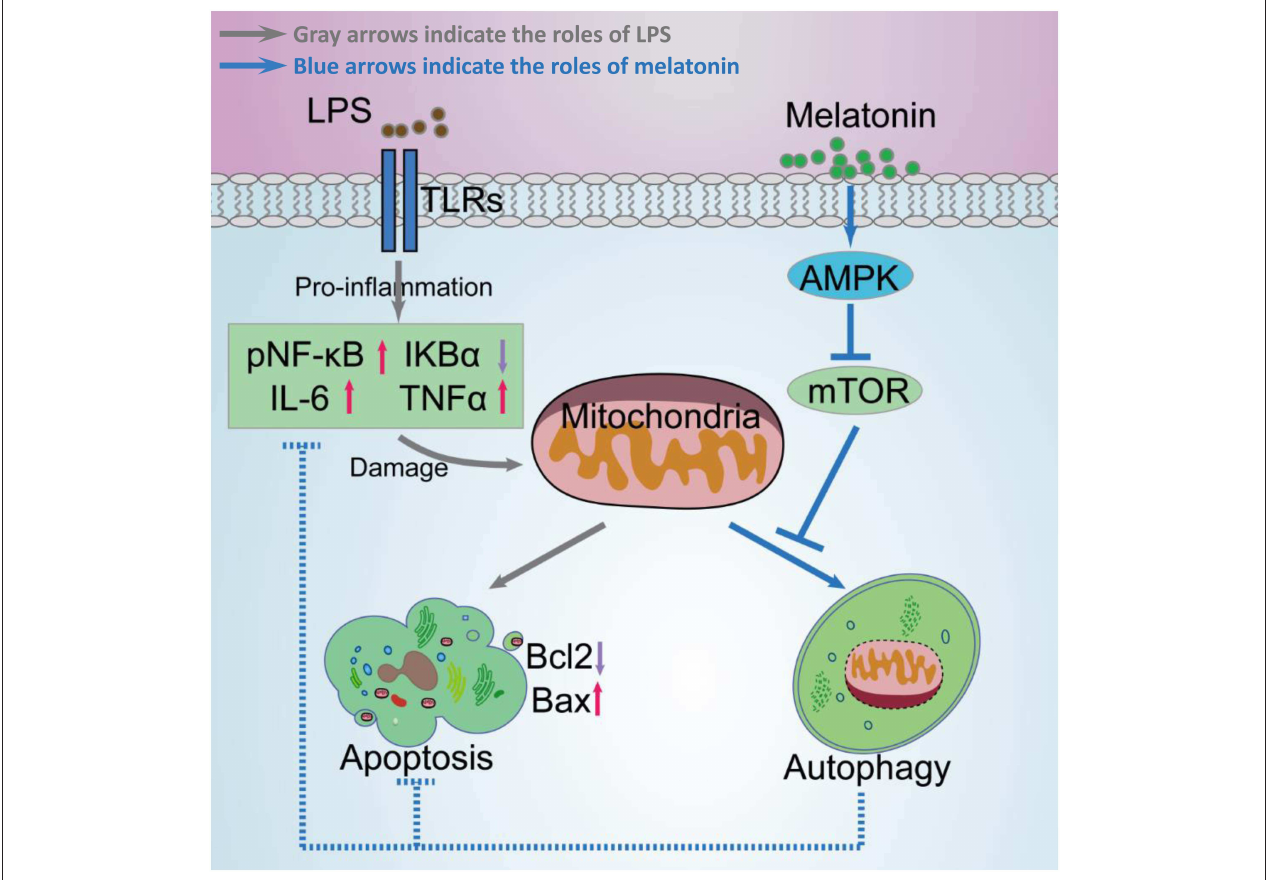
FIGURE 11 | Schematic diagram of melatonin induced protection against LPS-induced acute myocardial injury primarily via AMPK/mTOR/autophagy signaling. In this schematic diagram, gray arrows indicate the effects of LPS and blue arrows indicate the effects of melatonin. LPS significantly increases pNF- κ B, IL-6, TNF- α levels, and decreases I κ B α levels, which further damages mitochondrial function and increases apoptosis. Melatonin activated AMPK and further activated autophagy through suppressing mTOR. Activation of autophagy protected cell from mitochondria damage related apoptosis and decreased inflammation